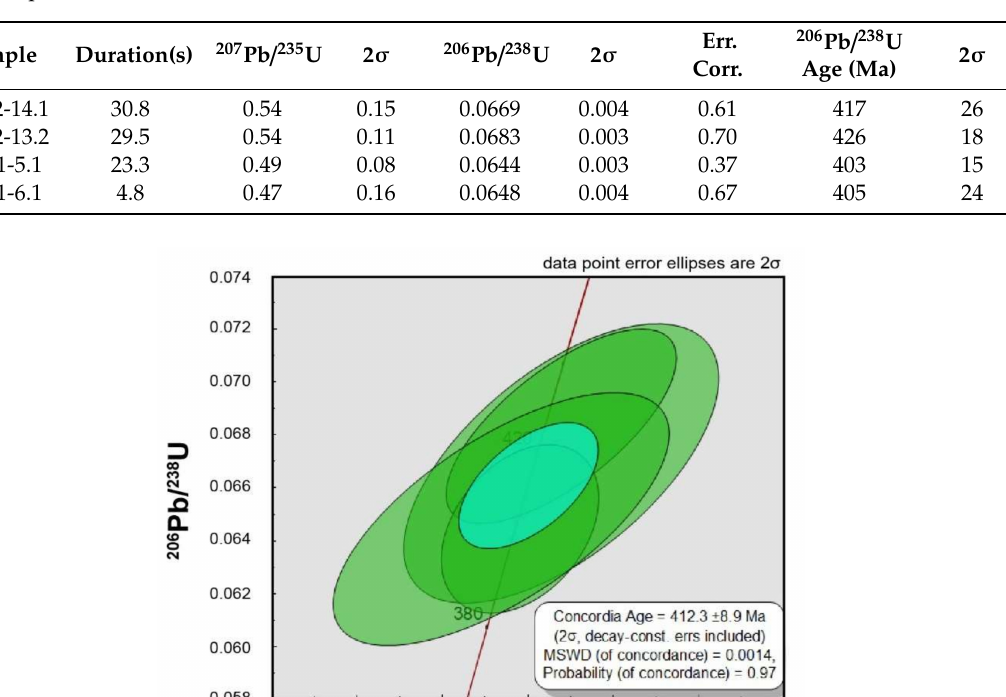
Figure 16. This population of eighteen analyses from a lamprophyre dyke is the second oldest U-Pb date produced using titanite from a lamprophyre dyke. The date listed above is a 204 Pb corrected weighted mean 206 Pb / 238 U date (data shown in Table 3). Error bars are to 2 σ . Table 4. U-Pb titanite geochronological data from youngest population in the lamprophyre dyke (samples 78-21 and 80-12).